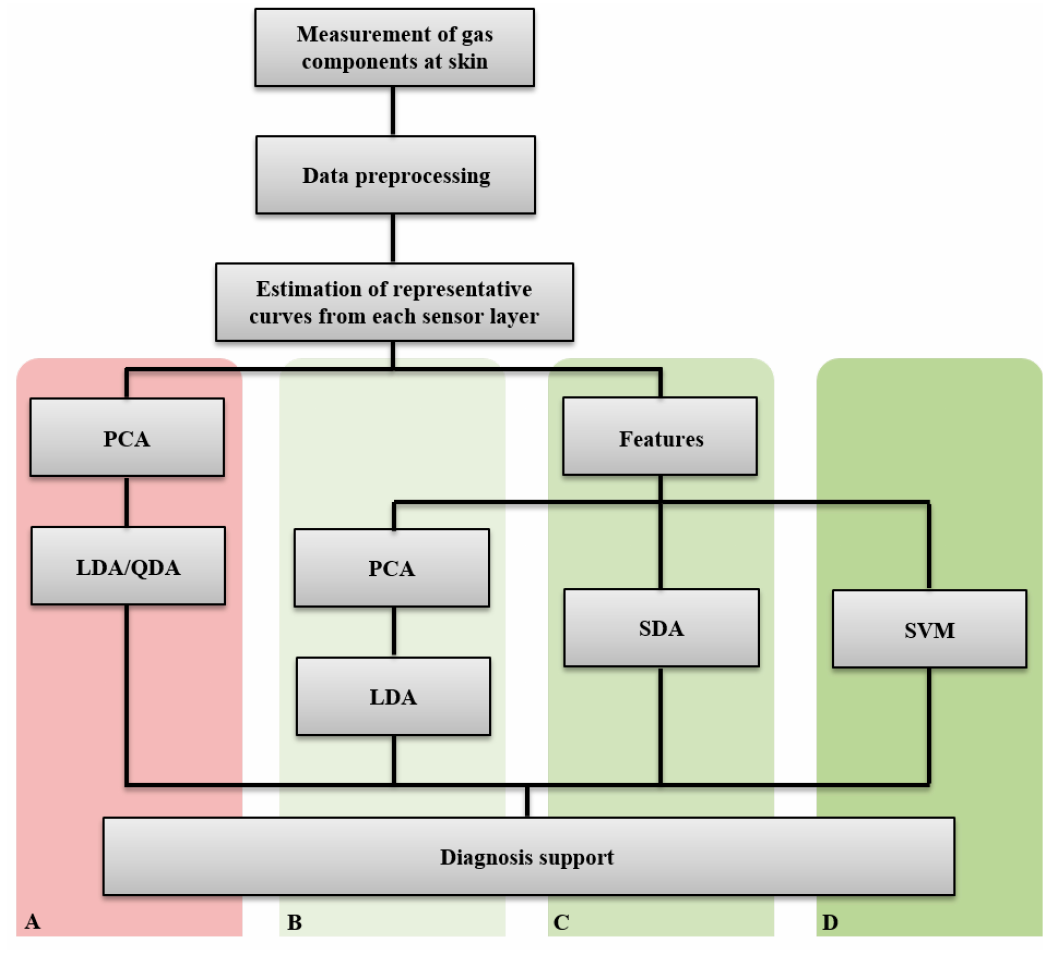
Figure 2. Scheme of data preprocessing and analysis (PCA—Principle Component Analysis; LDA/QDA—Linear/quadratic discriminant function analysis; SDA—Stepwise discriminant function analysis; SVM—Support vector machines; A, B, C, D—data analysis